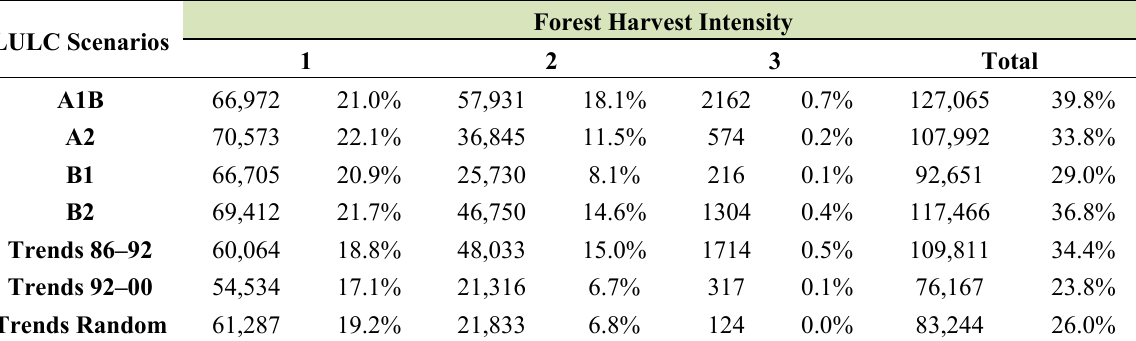
Table 4. Area (km 2 and %) of forest harvest in the Pacific Northwest for each modeled scenario. Harvest intensity values represent the periodicity of forest harvest, where values > 1 equal area harvested multiple